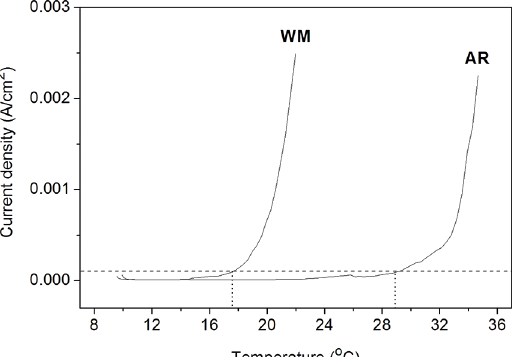
Figure 5. Curves for CPT determination in specimens WM and AR.